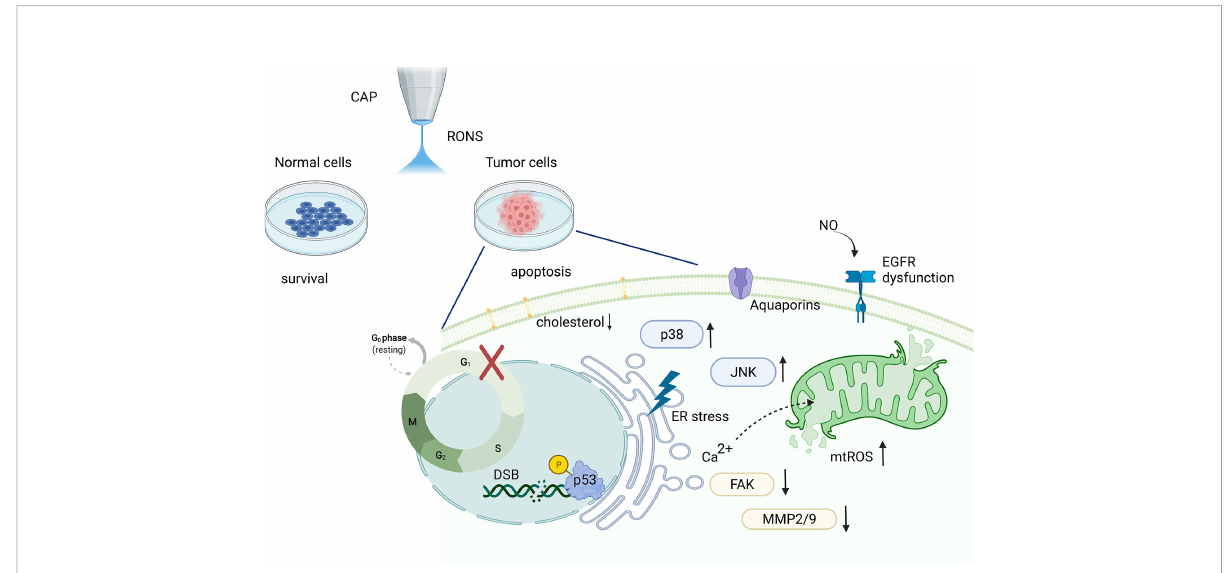
FIGURE 2 Schematics of CAP treatment of HNSCC cells and the potential underlying molecular mechanism. CAP demonstrates selectivity to cancer cells sparing adjacent healthy cells. In addition, CAP treatment induces a series of DNA damage and mitochondrial dysfunction in cancer cells. Moreover, CAP activates several tumor progression-associated signalling pathways, such as the p53 and MAPK signalling pathways. (CAP, cold atmospheric plasma; DSB, DNA double-stranded breakage; EGFR, epidermal growth factor receptor; ER, endoplasmic reticulum; FAK, focal adhesion kinase; MAPK, mitogen-activated protein kinases; MMP, matrix metalloproteinase; mtROS, mitochondrial reactive oxygen species; NO, nitric oxide; JNK, Jun N-terminal kinase; RONS, reactive oxygen and nitrogen species).